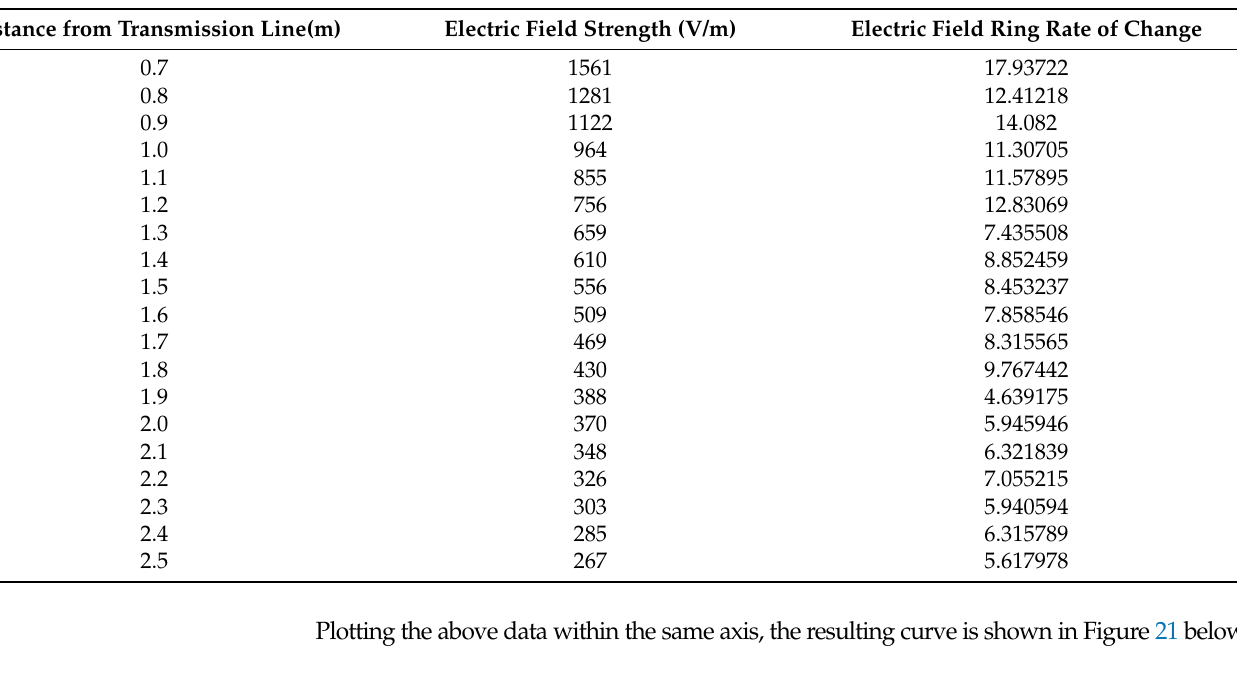
Table 5. Safety distance under different arrangement modes of 110 kV.